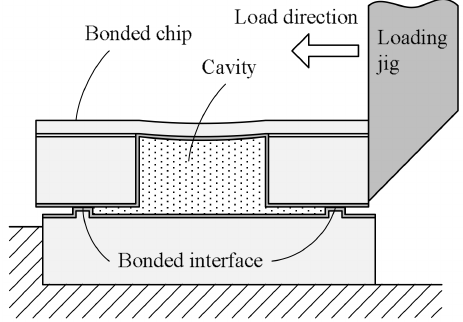
Figure 4. Schematic of bonding shear strength